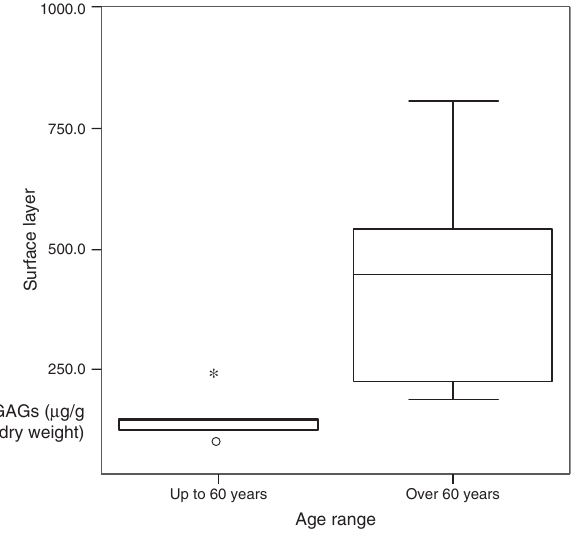
Box-plot of cover according to age